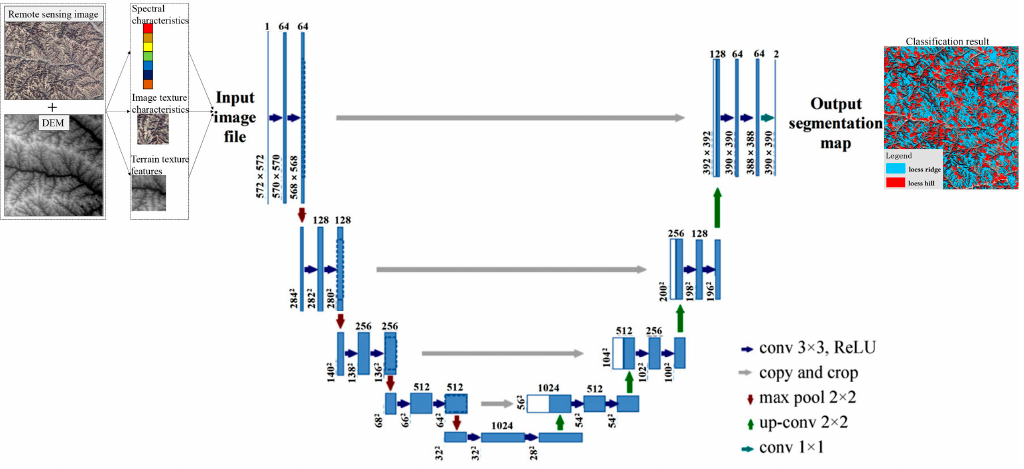
Figure 3. Sketch of the U-Net structure.